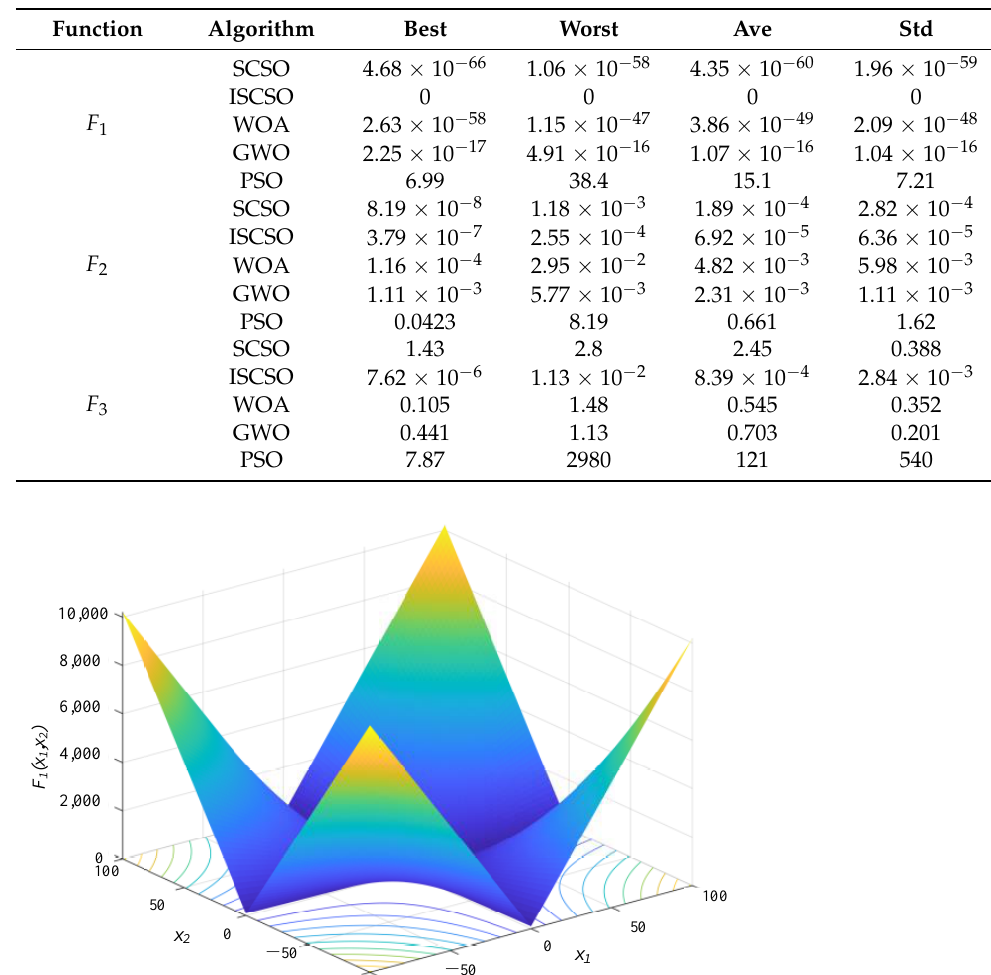
Table 1. Test Results for The Five Optimization Algorithms.